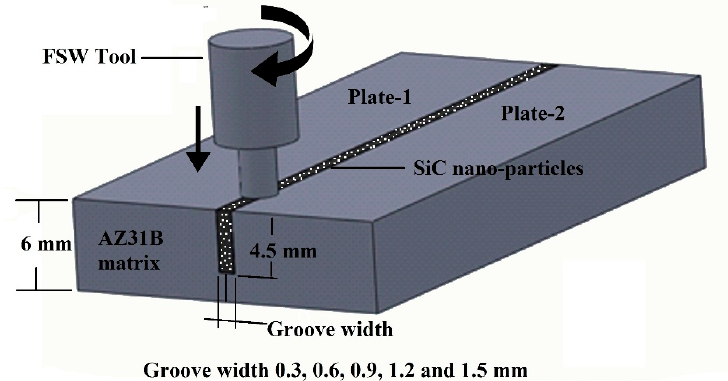
Figure 2. Schematic representation of the volume fraction sample.